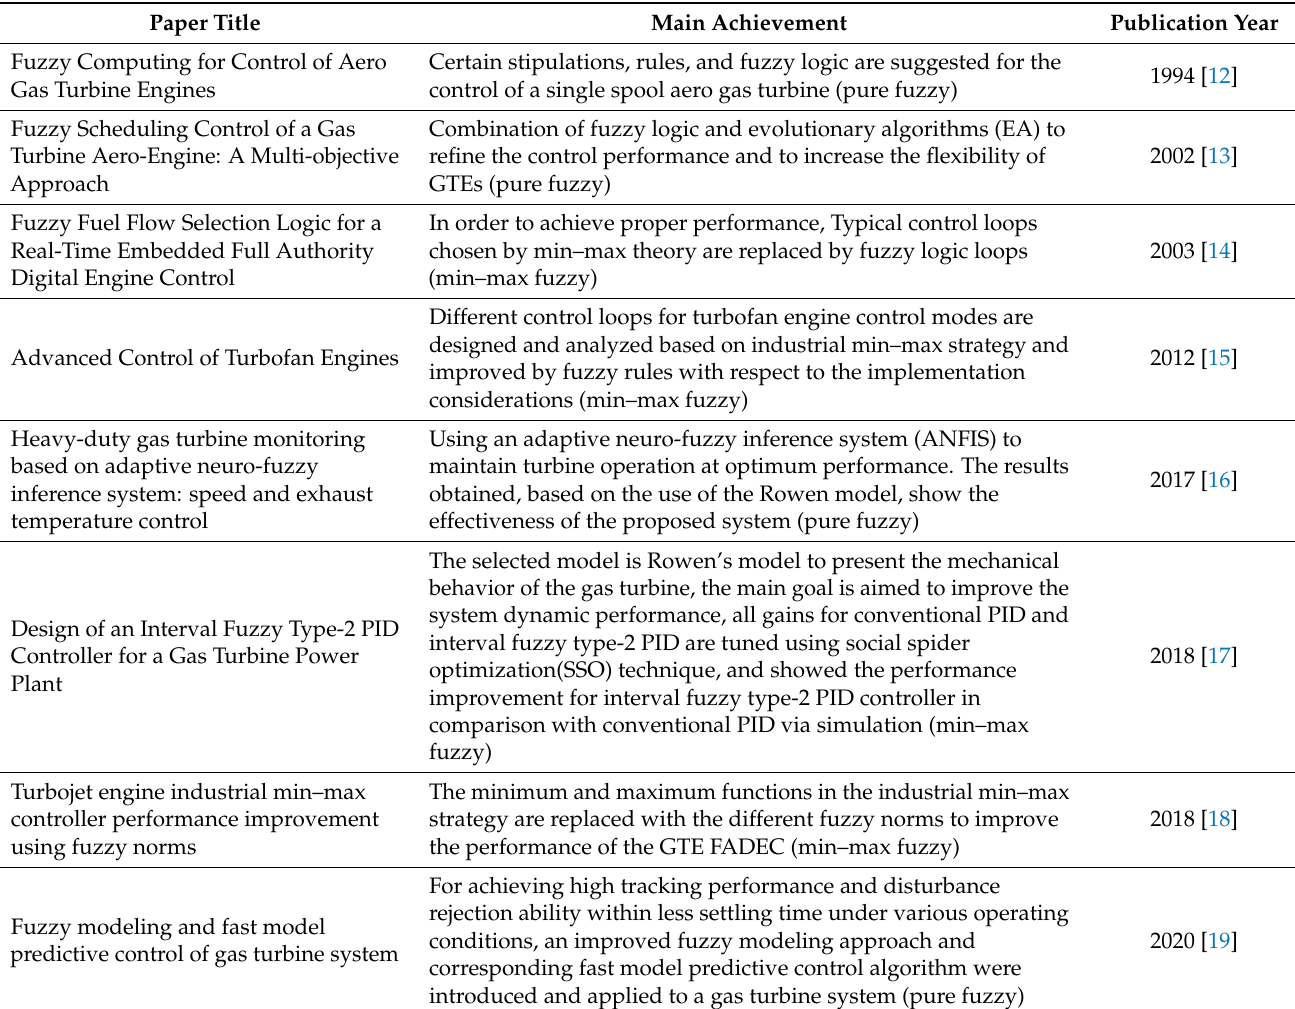
Table 1. Milestones in fuzzy controller design for gas turbine engines